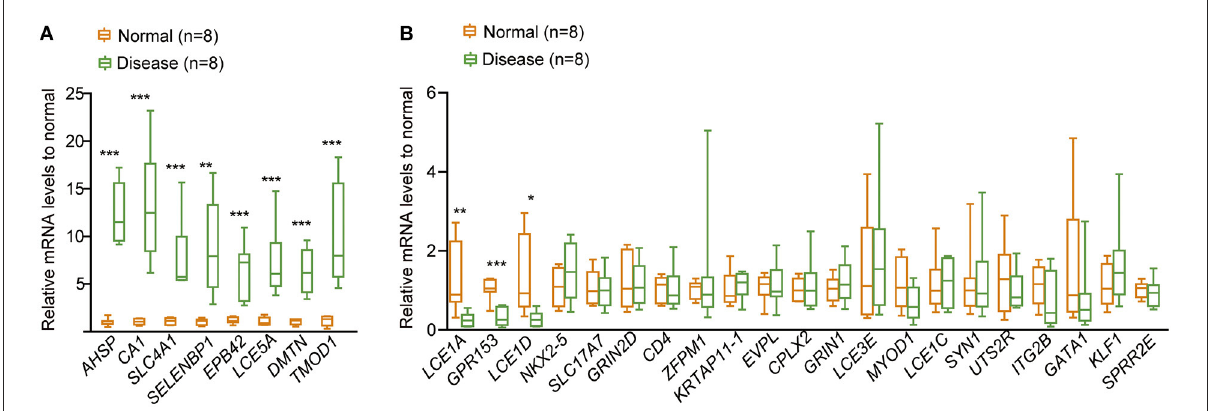
FIGURE10 qRT-PCR to detect the relative expression of the 30 hub genes in CHD. (A) The relative expressional levels of the eight up-regulated hub genes in CHD. (B) The relative expressional levels of the three down-regulated hub genes and genes that were not changed in CHD compared to the normal people. The statistical significance was calculated via one-way ANOVA , *** P < 0.001, ** P < 0.01, * P <